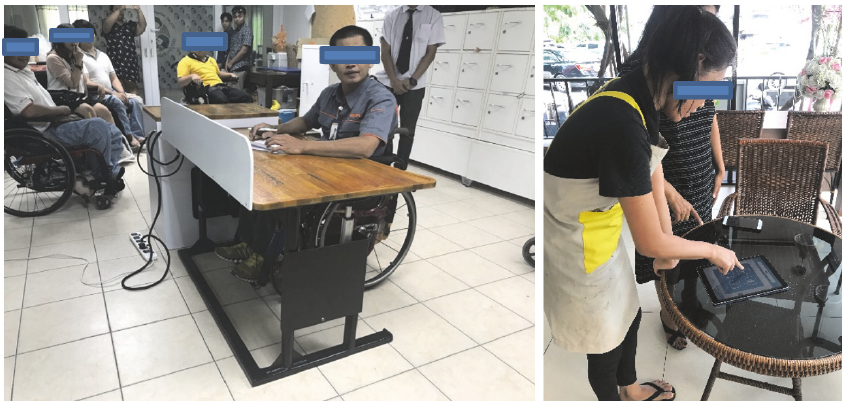
Figure 5: Post-use tests of the office furniture and workplace facilities (application) to improve work effectiveness of people with physical disabilities and the deaf in department stores, retail and wholesale companies for 15 people [2]. Source: the current